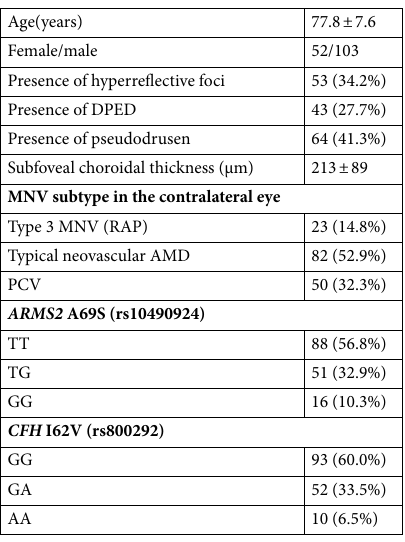
Table1. Baseline demographic and genetic characteristics. MNV, macular neovascularization; DPED, drusenoid pigment epithelial detachment; RAP, retinal angiomatous proliferation; AMD, age-related macular degeneration; PCV, polypoidal choroidal